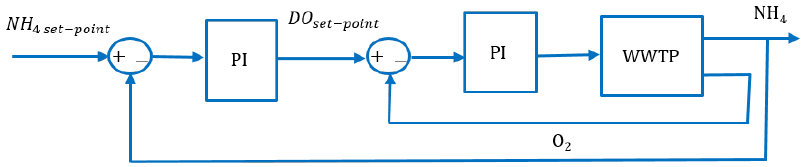
Figure 11. Ammonium-based PI control structure.